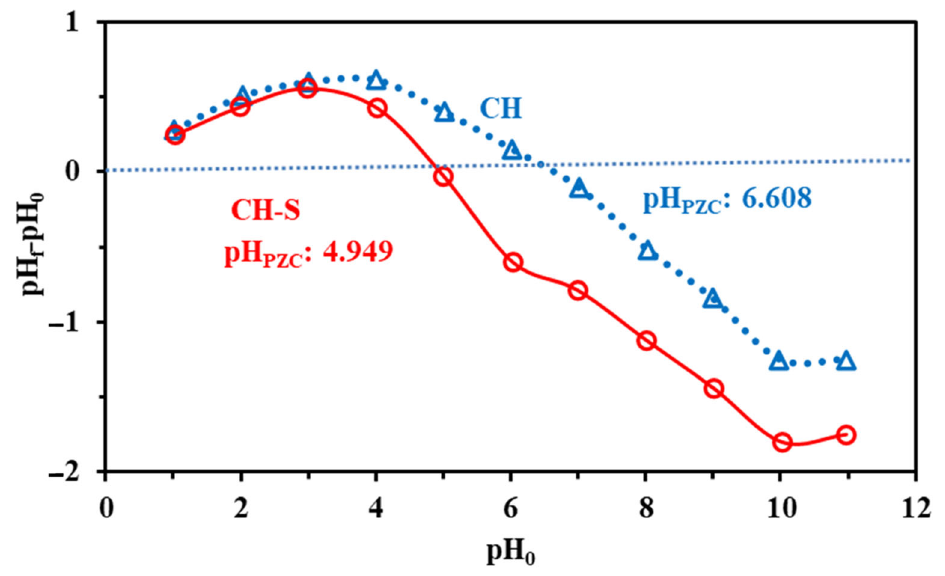
Figure 5. pH pzc of the CH and CH ‐ S sorbents.